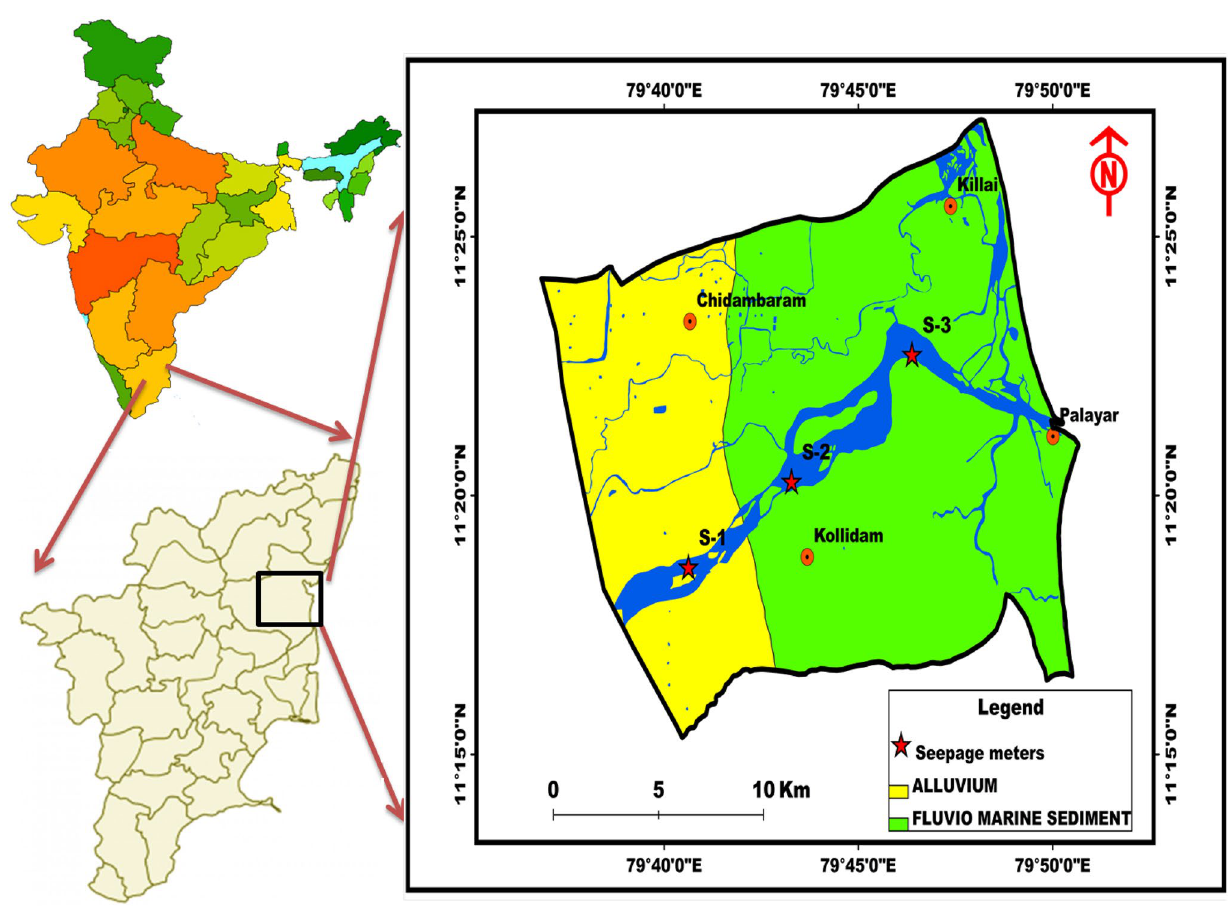
Fig. 1 Seepage location and geology map of the Coleroon